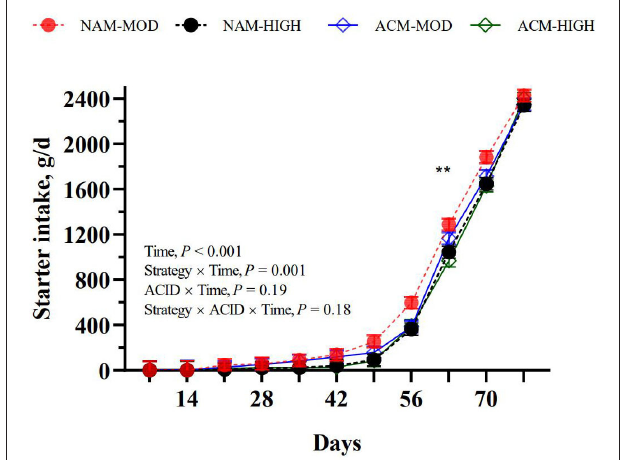
FIGURE 1 | Effect of milk feeding strategy and milk acidification on starter intake in calves assigned to (1) non-acidified milk at 6 L (NAM-MOD); (2) acidified milk at 6L (ACM-MOD); (3) Non-acidified milk at 12L (NAM-HIGH) and (4) Acidified milk at 12L (ACM-HIGH) per day. Strategy: milk feeding strategy (MOD or HIGH). ACID: milk acidification (NAM or ACM). Time represents a week. Values are presented as weekly LSM. **Indicates significant difference between calves fed moderate and high milk volumes ( P <